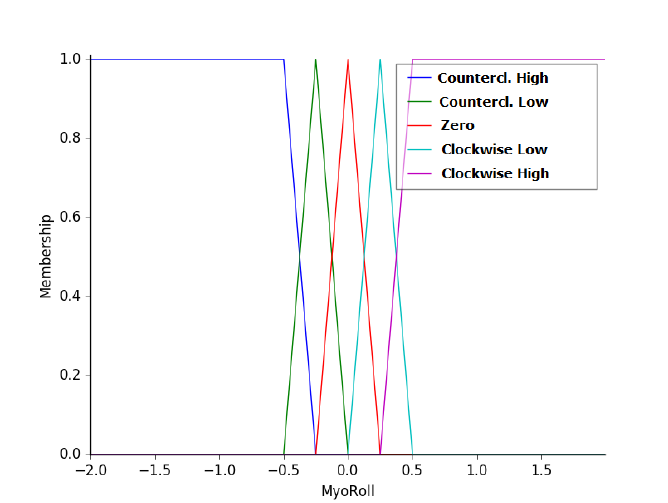
Figure 7. Membership functions of the variable MyoRoll.